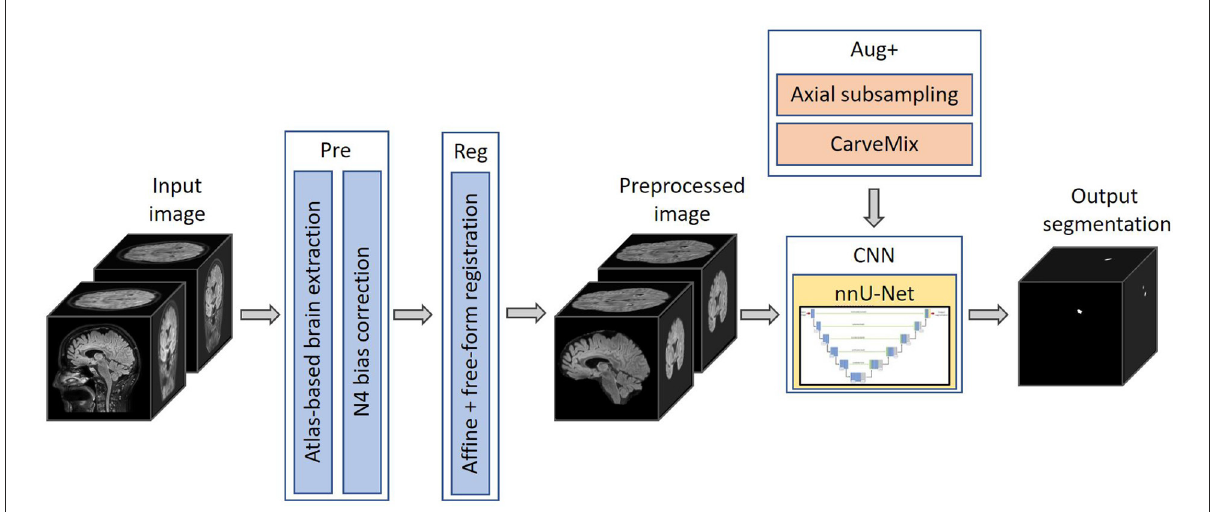
FIGURE1 The proposed 3D framework for multiple sclerosis new lesion detection and segmentation. Framework comprises of brain extraction and N4 bias correction (Pre), intra-subject registration (Reg), imaging and lesion-aware data augmentations (Aug+), and nnU-Net. The pipeline takes input the baseline and follow-up FLAIR MRI scans, and outputs the proposed binary segmentation for new